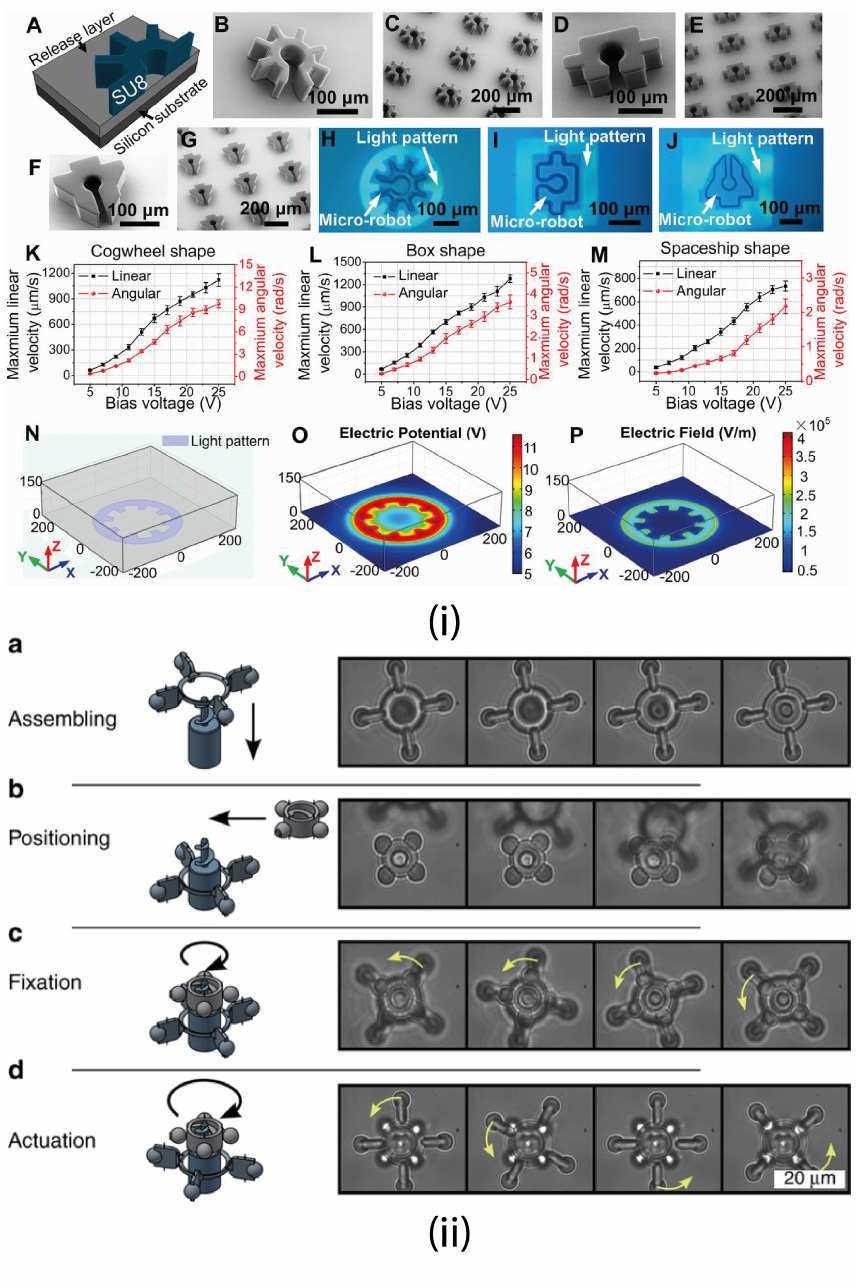
Figure 3. Micro manipulation using light actuation ( i ) ( A – G ) Fabrication of micro tools, ( H – J ) Differ- ent light patterns to manipulate the micro tools, ( K – M ) Performance curves for various shapes of micro tools, ( N ) Three-dimensional simulation of an OET device with a purple light pattern projected onto an a-Si:H surface. XY plots at Z = 1.1 m of simulated, ( O ) Electric potential distribution and ( P ) Electric field distribution for a device driven at 20 Vpp (25 kHz), with heat maps indicating the simulated electric potential and field (blue = low, red = high). The ( N – P ) axis dimensions are in micrometers. Copyright (2019) National Academy of Sciences [76], and ( ii ) ( a – d ) An optical screw- wrench system for micro-assembly using optical tweezers [73]. Reproduced under the terms of the CC-BY